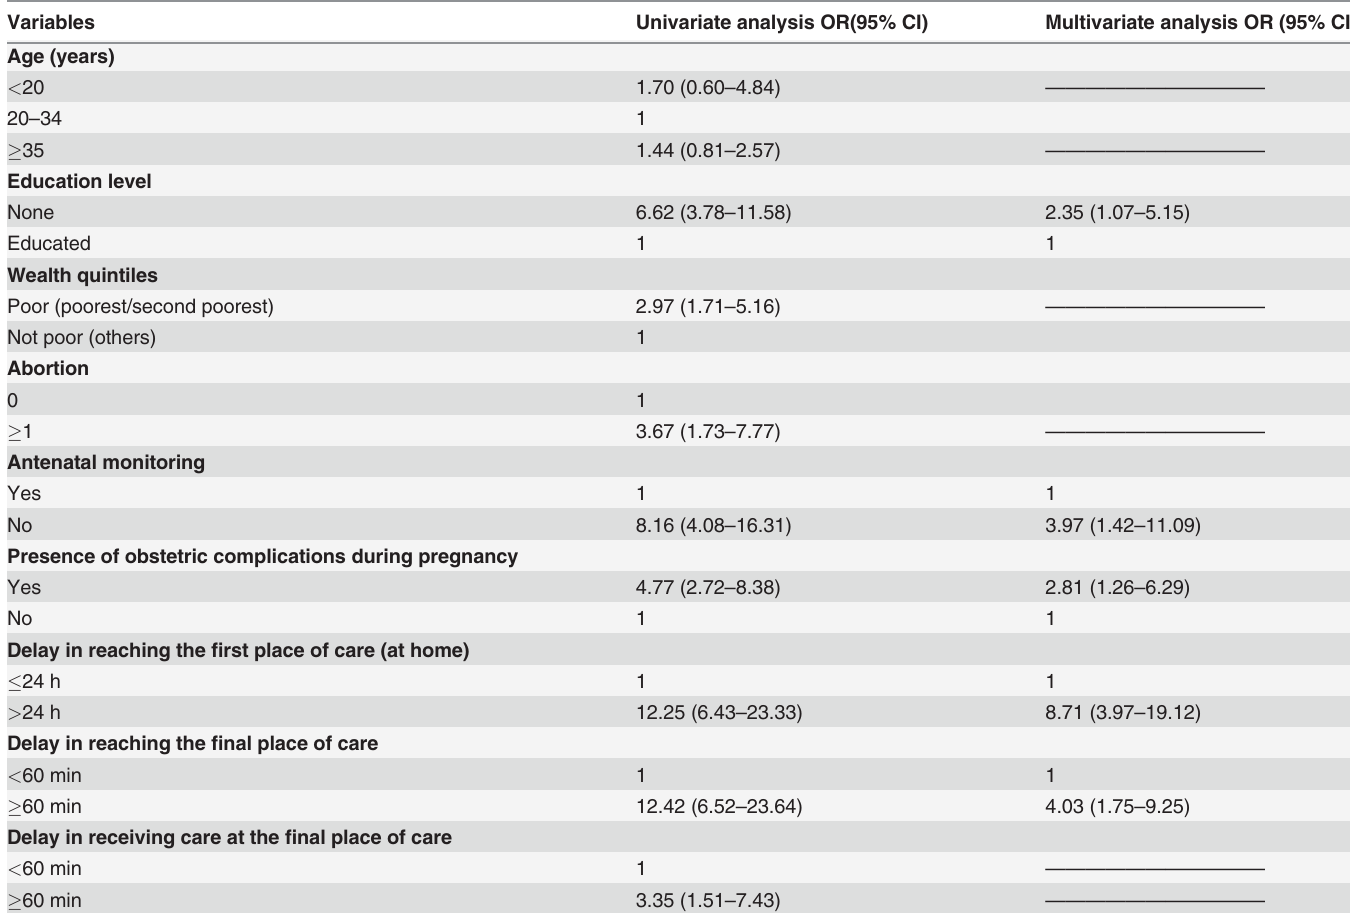
Table 6. Analysis of near-miss determinants by binary logistic